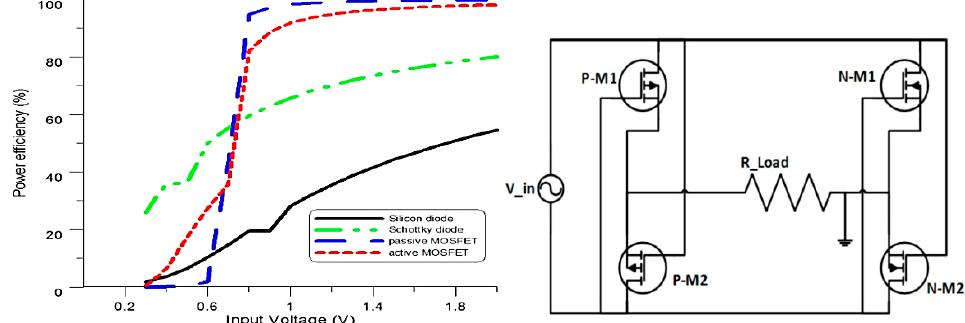
Figure 7. Power efficiency of full-wave rectifiers as a function of input voltage V in ( left ); full-wave rectifier constituted by two PMOS (P-M1, P-M2) and two NMOS (N-M1, N-M2) ( right ) [40].